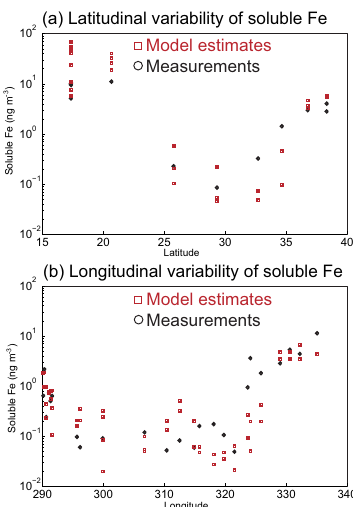
Figure 4. Comparison of simulated (red squares) and observed (black circles) soluble Fe concentration (ngm − 3 ) during the (a) 2010 and (b) 2011 US GEOTRACES cruises over the North Atlantic (Wozniak et al., 2013, 2015). The number of modeled data points (84) is larger than the measurements (37), because each daily average is calculated for each sampling date at each center of cruise